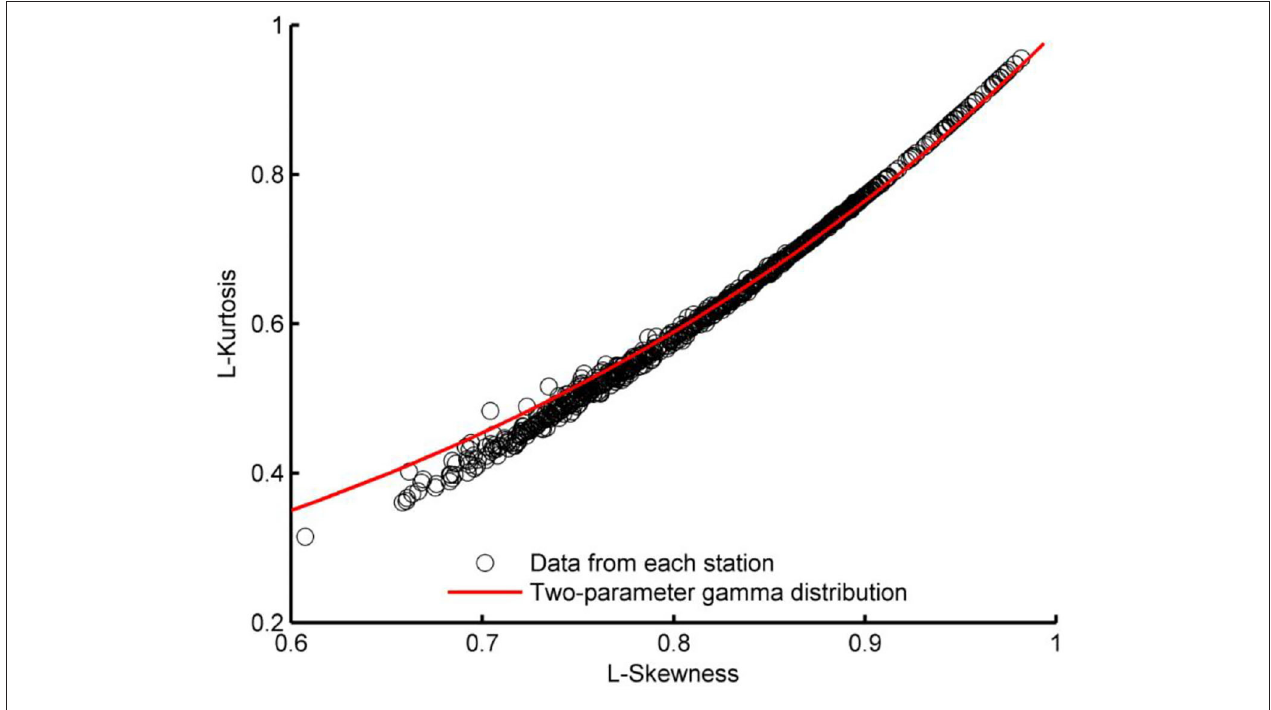
FIGURE 3 | L-statistics of fitted gamma distribution for all 665 records used.